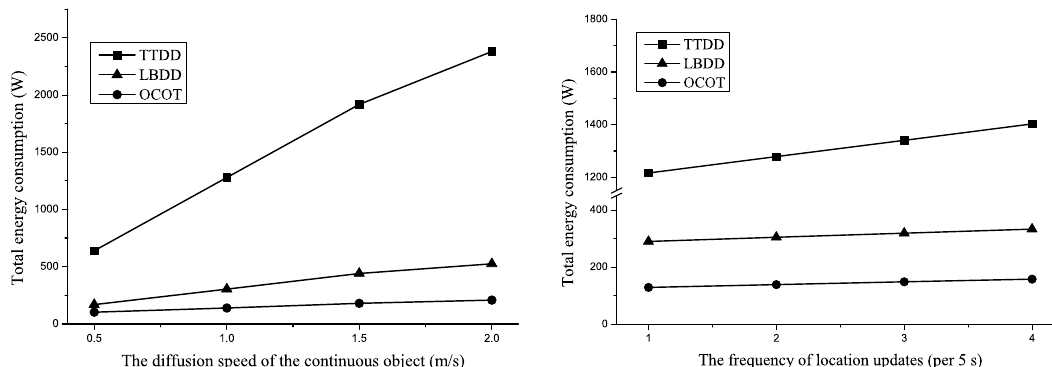
Figure 16. Comparison of total energy consumption according to the diffusion speed of the continuous object ( left ) and the frequency of location updates ( right ).